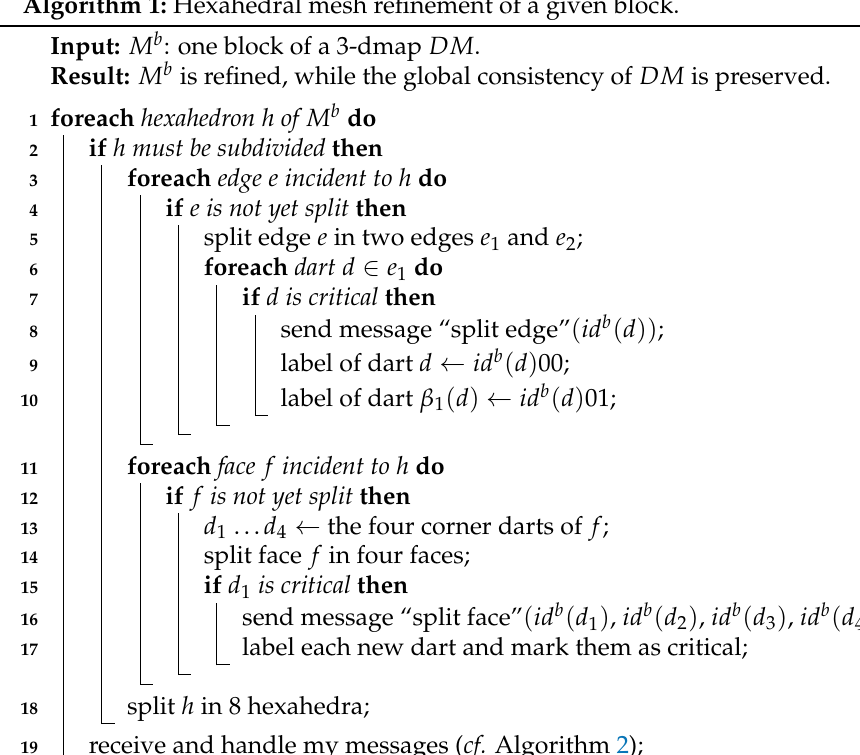
Algorithm 1: Hexahedral mesh refinement of a given